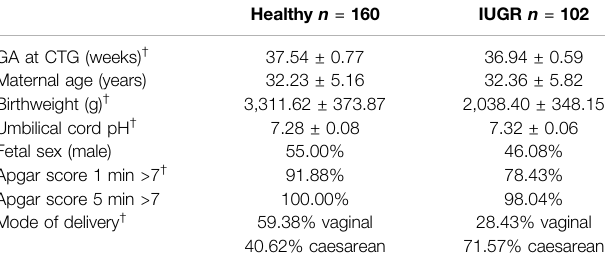
TABLE 1 | Clinical data for the healthy and IUGR populations. Healthy n = 160 IUGR n =